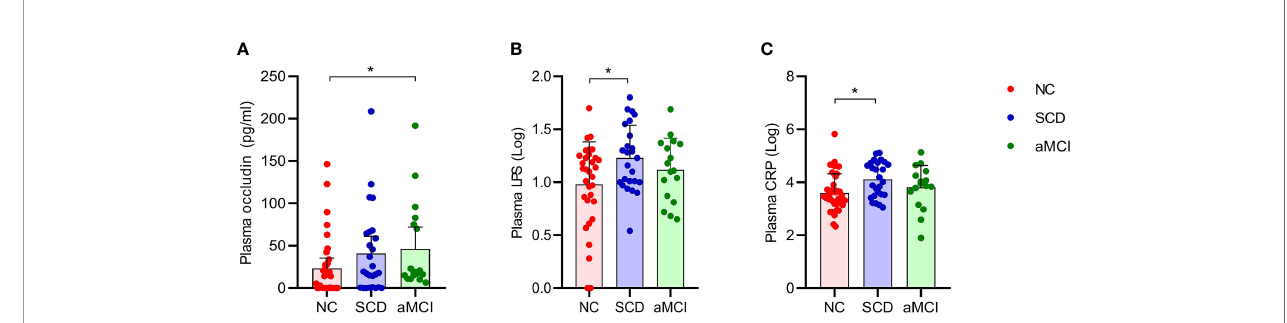
FIGURE 5 | (A – C) Analysis of plasma factors levels between NC and pAD patients. The Y axis represents the concentration of plasma occludin, Log 10 LPS, and Log 10 CRP. The X axis represents the groups and the error bar means standard deviation. Wilcoxon rank sum test shows a signi fi cant difference in the plasma occludin levels between the aMCI group and the NC group (A) (*P-value < 0.05, Wilcoxon rank sum test). Wilcoxon rank sum test shows that the plasma Log 10 LPS and Log 10 CRP levels in the SCD group are signi fi cantly higher than those in the NC groups (B, C) .